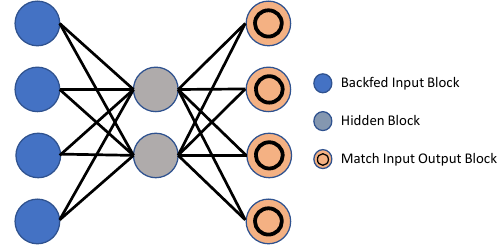
Figure 10. Autoencoder block